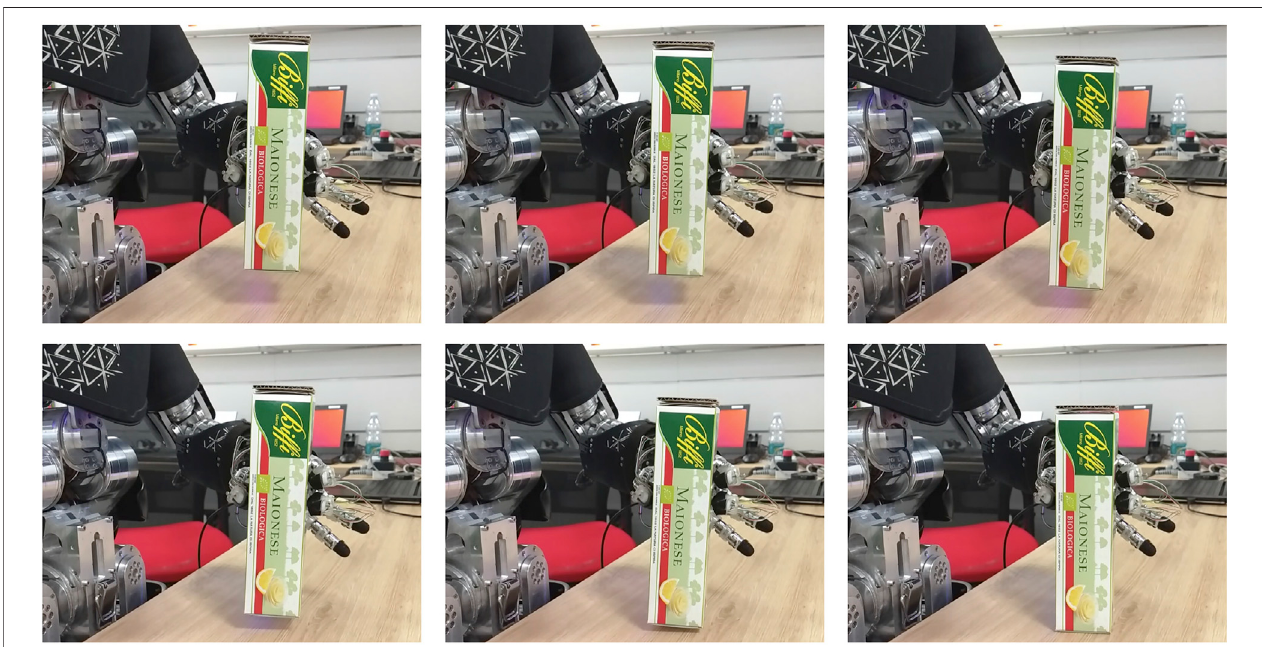
FIGURE 4 | Outcome of the controlled sliding experiment with the box-shaped